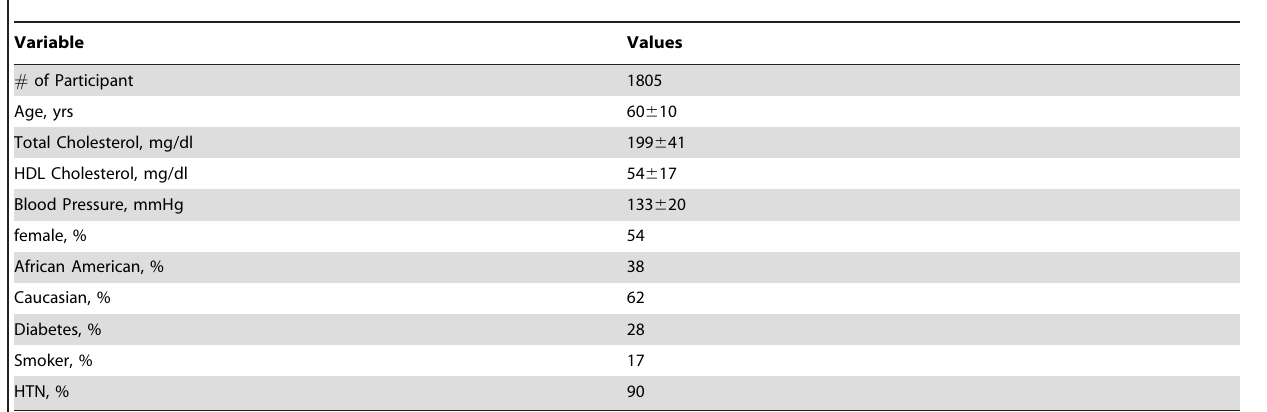
Table 1. Baseline characteristics of the NHANES